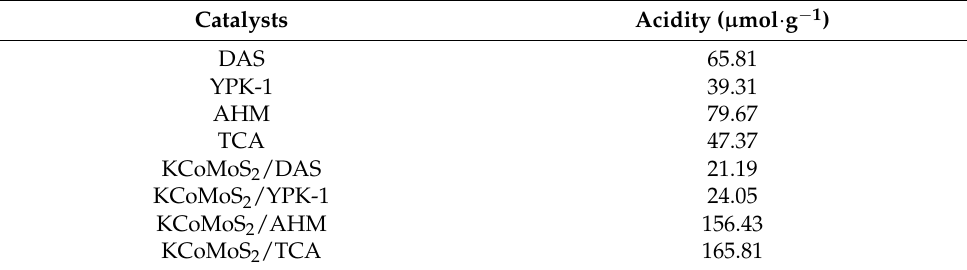
Table 3. Total acidity of AC-supported MoS 2 catalysts.